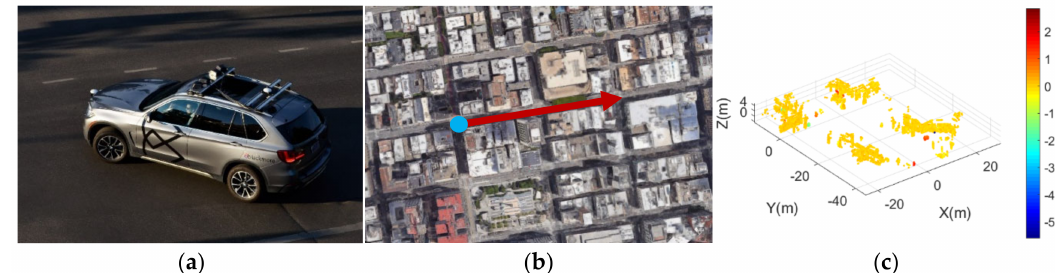
Figure 1. ( a ) The Doppler LiDAR system; ( b ) the test site (blue dot: the sensor; red arrow: driving direction); ( c ) one frame point cloud color coded by absolute radial velocity (unit: m/s).